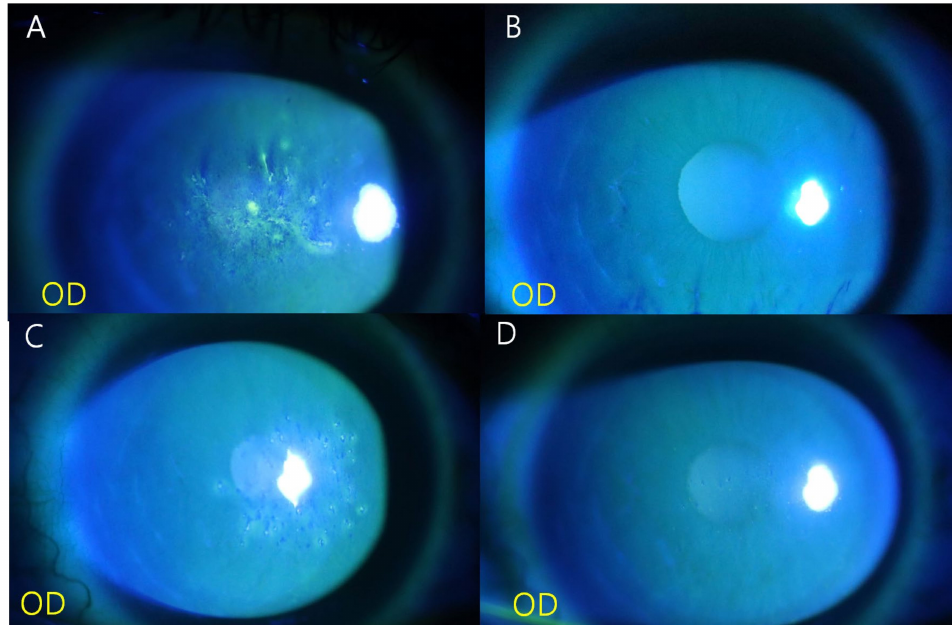
Figure 1. At the initial visit, a dendritic corneal lesion was observed in the right eye ( A ). Three weeks after the initial visit, complete recovery of the corneal epithelium is noted ( B ). At 5 weeks, elevated cornea lesions with a discrete round to oval shape scattered diffusely are noted in the patient’s right eye ( C ) and complete recovery of the corneal epithelium is noted at 10 weeks ( D ). One week after the initial presentation, the BCVA of the right eye improved to